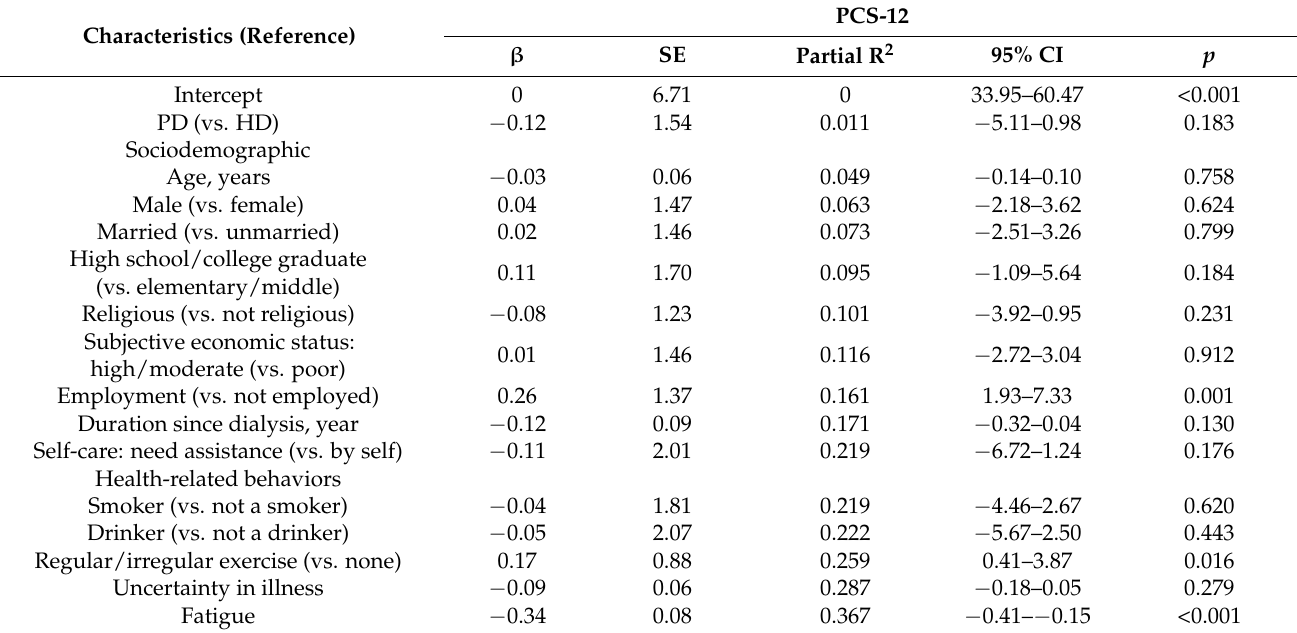
Table 3. Factors affecting the physical health-related quality of life ( n =